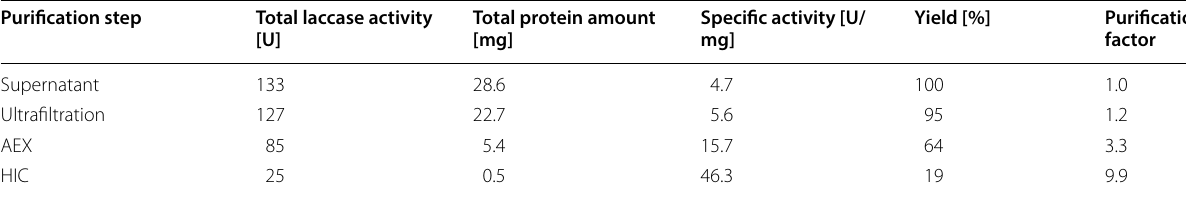
Table 1 Purification of Lcc8 from culture